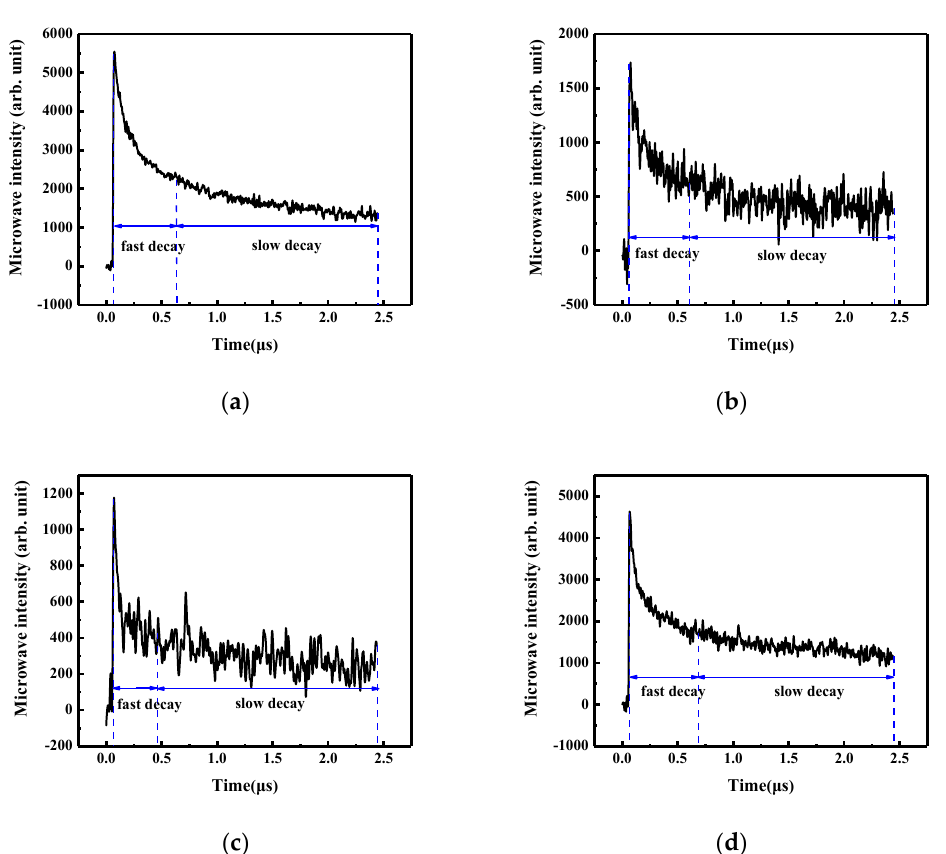
Figure 6. Photoconductivity responses of SnO 2 :Si films: ( a ) Pure SnO 2 , ( b ) SnO 2 :5 at.% Si, ( c ) SnO 2 :10 at.% Si, ( d ) SnO 2 :15 at.% Si.